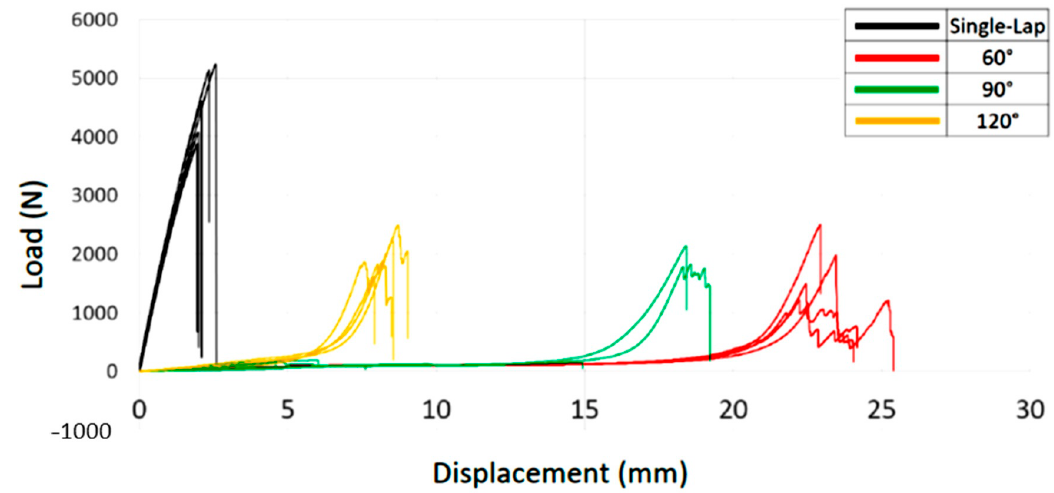
Figure 7. Load vs. displacement graph for the investigated test samples.